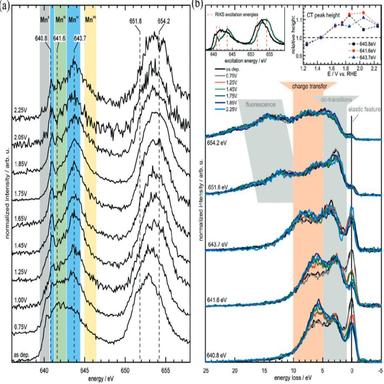
(a) In-situ XAS (PFY) at the Mn L2,3-edges for MnOx in a borate buffer (0.1 M, pH 9.2) at specified potentials (vs. RHE). Dashed lines show energies used to collect RIXS spectra. (b) In-situ energy loss spectra of scattered photons (RIXS) obtained at 23 ± 2 ◦C for MnOx in borate buffer (0.1 M, pH 9.2) with no potential applied (black) and at 0.75 (gray), 1.25 (red), 1.45 (light green), 1.75 (dark green), 1.85 (dark blue), and 2.25 V vs. RHE (turquoise) . (For interpretation of the references t